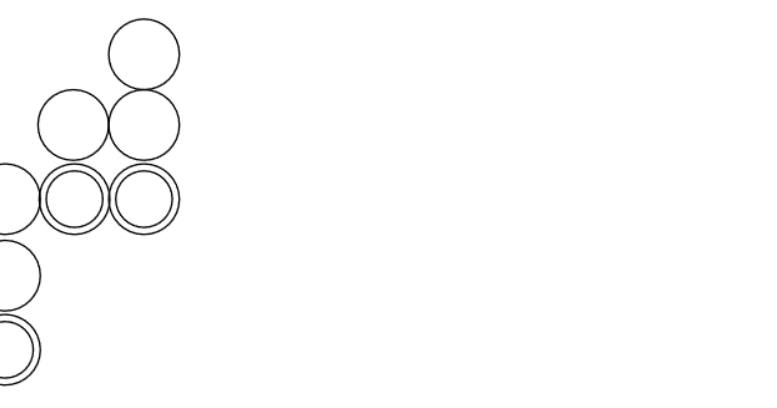
Figure 9. pyramid p 3, i , t q and pyramid p 3, i ` 2, t ` 2 q with p i ` 2, t ` 2 q as a secondary vertex, forming a